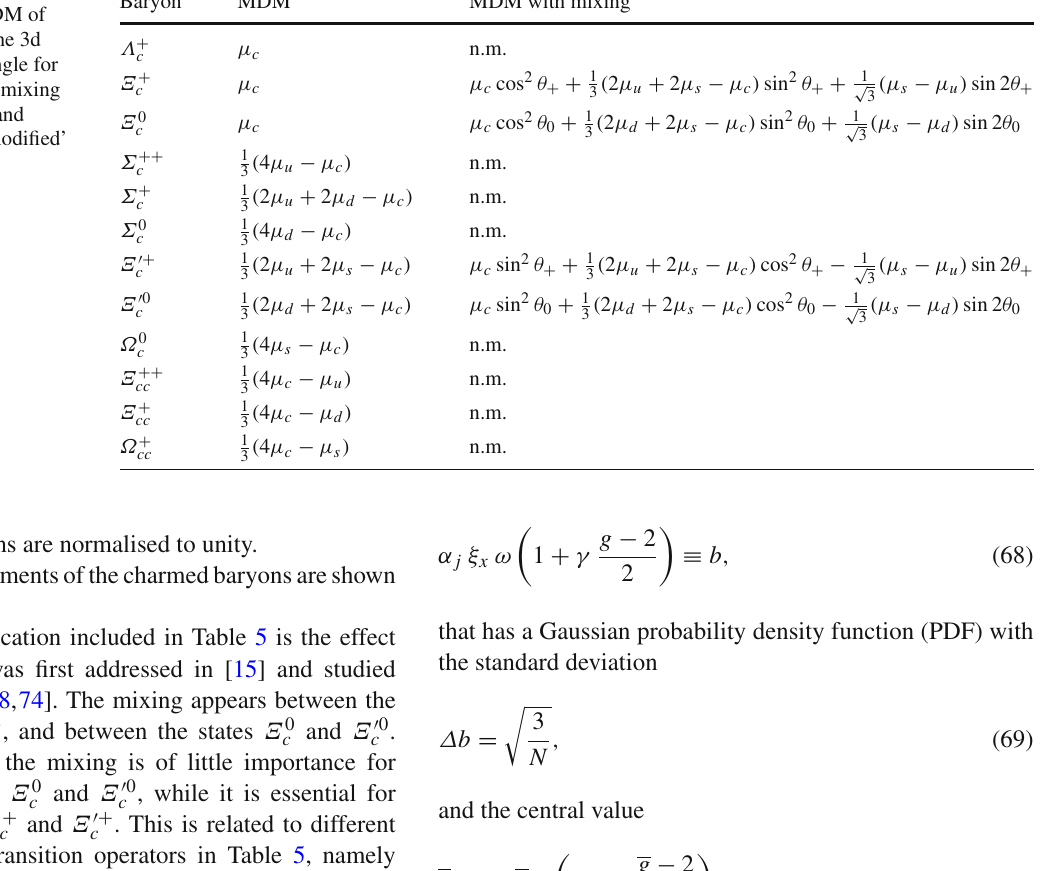
Table 5 MDM of charmed Baryon MDM MDM with baryons in terms of MDM of constituent quarks. In the 3d column θ + is mixing angle for Ξ + Ξ (cid:6)+ θ 0 is mixing c and c , and angle for Ξ 0 c and Ξ (cid:6) 0 c , and ‘n.m.’ stands for ‘not modified’